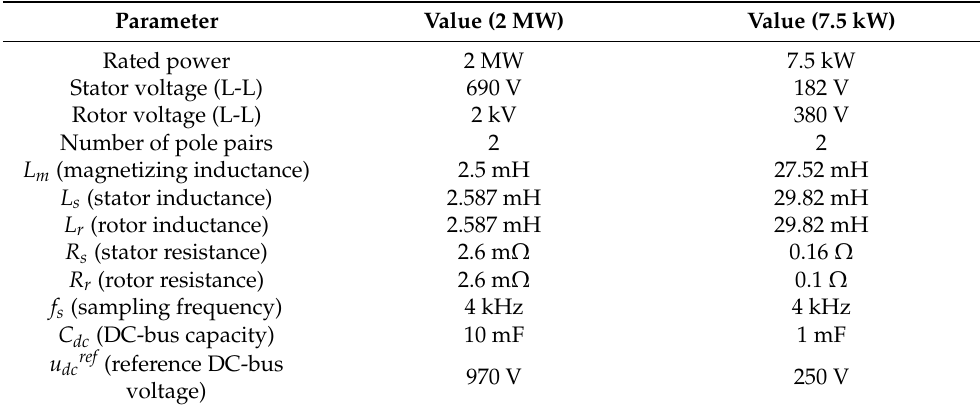
Table A1. Parameters of the full-scale simulated and small-scale experimental DFIG-DC